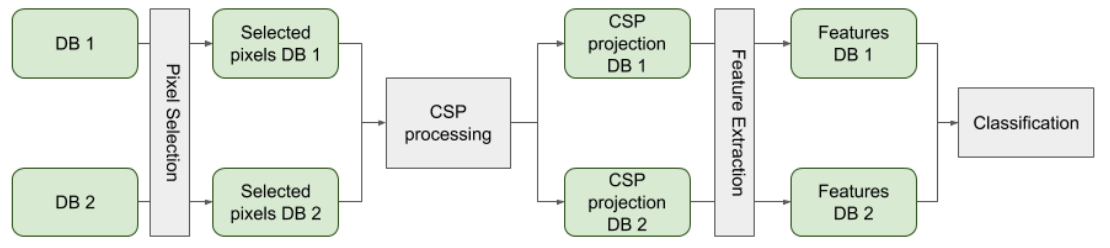
Figure 2. An overview of the full process of the presented